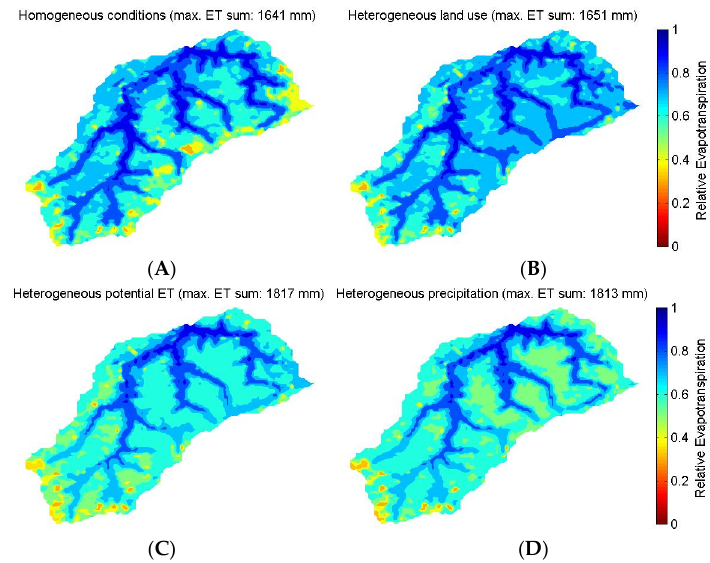
Figure 10. Pattern of actual evapotranspiration for simulations Erk ( A ), Erk_LN ( B ), Erk_LN_PET ( C ) and Erk_LN_PET_P ( D ). Evapotranspiration is given relative to the maximum of the actual evapotranspiration sums of 2010 and 2011 as specified in the brackets.